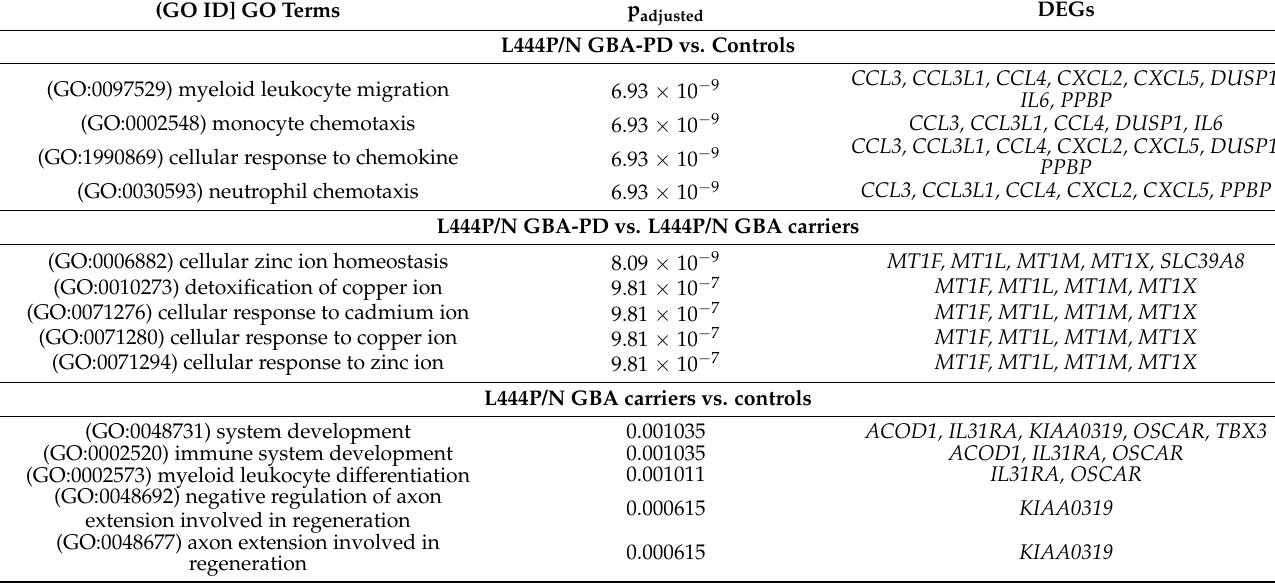
Figure 1. Volcano plot for DEGs between the studied groups (FDR < 0.05 and |FC| > 1.5); the upregulated genes are represented by red dots and the downregulated genes are represented by blue dots. ( A ). L444P/N GBA-PD patients and controls, ( B ). L444P/N GBA carriers and controls, ( C ). L444P/N GBA-PD patients, and L444P/N GBA carriers. (GBA-PD— Parkinson’s disease associated with mutations in the GBA gene; GBA carriers—asymptomatic GBA mutation carriers; DEGs—differentially expressed genes). Table 2. Functional clusters selected according to the results of the GO analysis between L444P/N GBA-PD patients, L444P/N GBA carriers, and